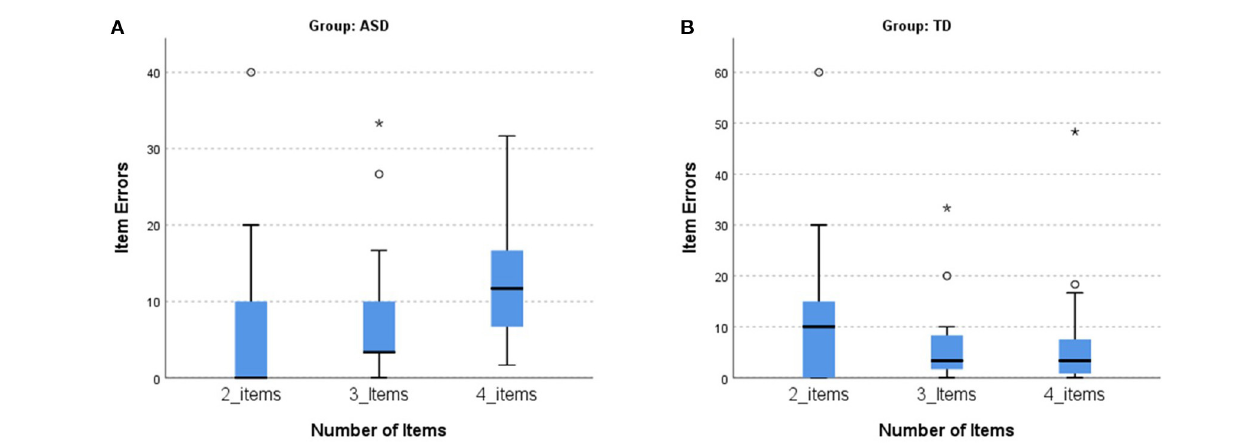
FIGURE 2 | Trend analysis of the number of items: item errors. (A) Association between the number of item errors with the increasing number of items in the ASD group. The number of item errors is higher with the increase of cognitive load (with higher number of items per condition) in the ASD group. (B) No association between the number of item errors with the increasing number of items in the TD group. In the TD group, the number of item errors is similar in the different conditions, despite the increasing number of items (cognitive load). ASD, autism spectrum disorder group; TD, typical neurodevelopment group. The symbol * is the representation of an extreme outlier.